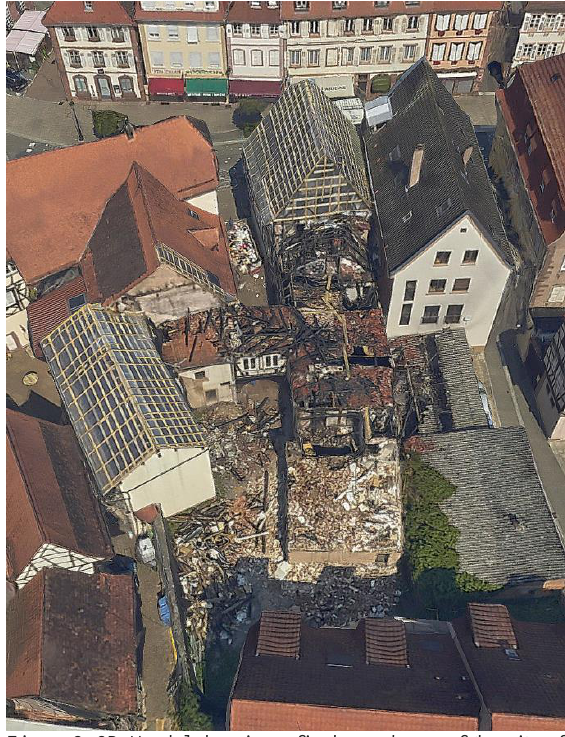
Figure 2: 3D Model showing a fire burned area of the city of Wissembourg/France generated with Skyline Software out of an OIS-Xl 4B Mission